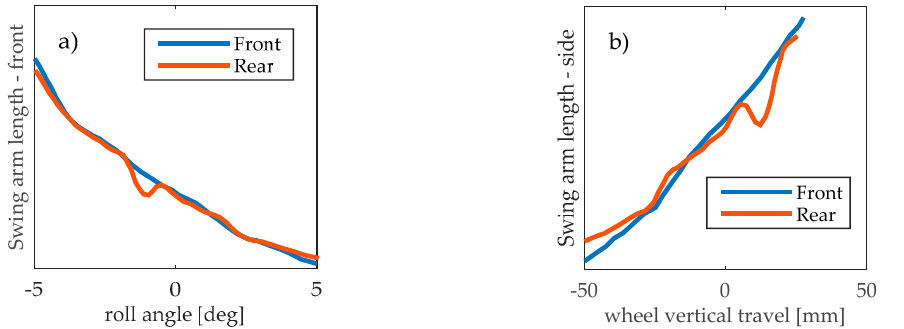
Figure 4. Front and side views of the experimentally validated vehicle model. The grey arrows represent the anti-roll and anti-dive/lift force generated by in-wheel motor (IWM) torque control to suppress the roll and pitch motion, respectively.